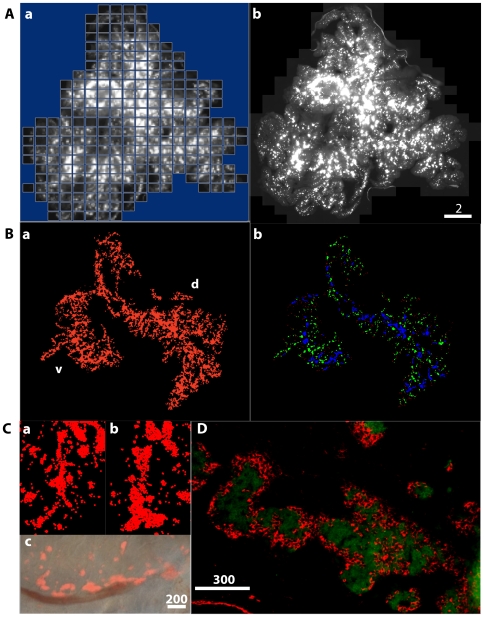
Imaging the entire distribution of beta-cells in situ.
A: Virtual slice. a. A series of contiguous images of a specimen was taken using a 10x objective. Note a mosaic image covering the entire distribution of beta-cells. b. A virtual slice that combines all of the images into a single image montage. B:
a. The entire distribution of beta-cells in the intact pancreas at P7 (d: dorsal, v: ventral). b. Three distinct population of beta-cell clusters are color-coded. Blue: interconnected islets, green: spherical shaped islets, and red: small clusters of beta-cells (<10 cells). C: Interconnected islets. a. P7; b. P12; c. A stretch of interconnected islets in the neonatal pancreas (P10). A merged image of fluorescent and bright field images of interconnected islets. Islets are often seen clustering along the large blood vessels. Scale bar is 1 mm. D: Immunohistochemical analysis of coalescent islets (P13). Insulin (green) and glucagon (red) staining is shown. A stretch of a continuous elongated structure with rows of alpha-cells spanning each islet-like mass is observed in the neonatal pancreas. Scale bar is 300 µm.